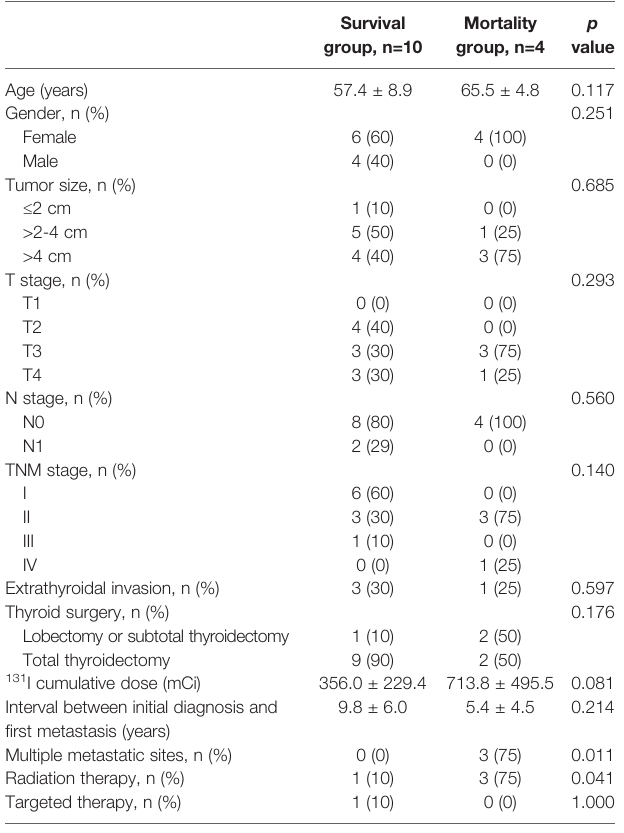
Survival Mortality group, n=10 group,